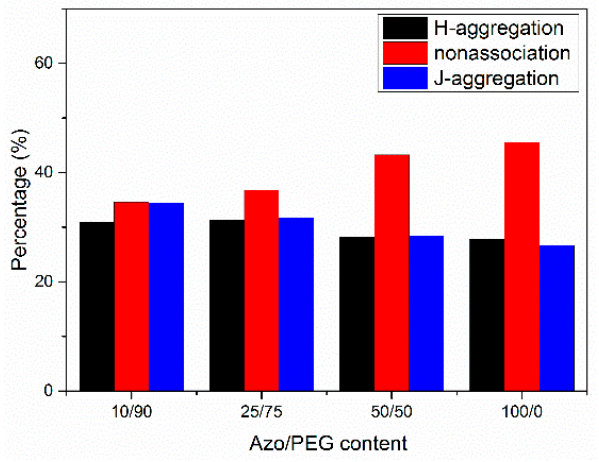
Figure 5. The populations of different organizations of azobenzenes in Azo/PEG complexes with regard to complex compositions.